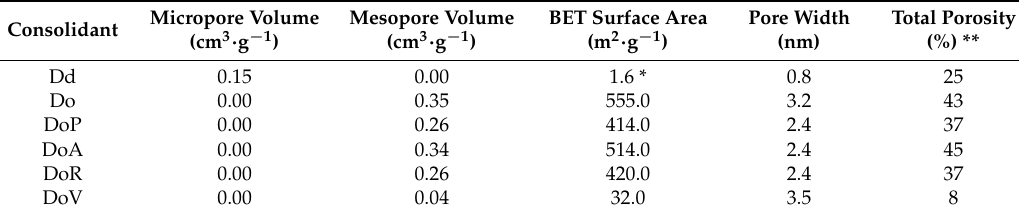
Table 3. Texture parameters of